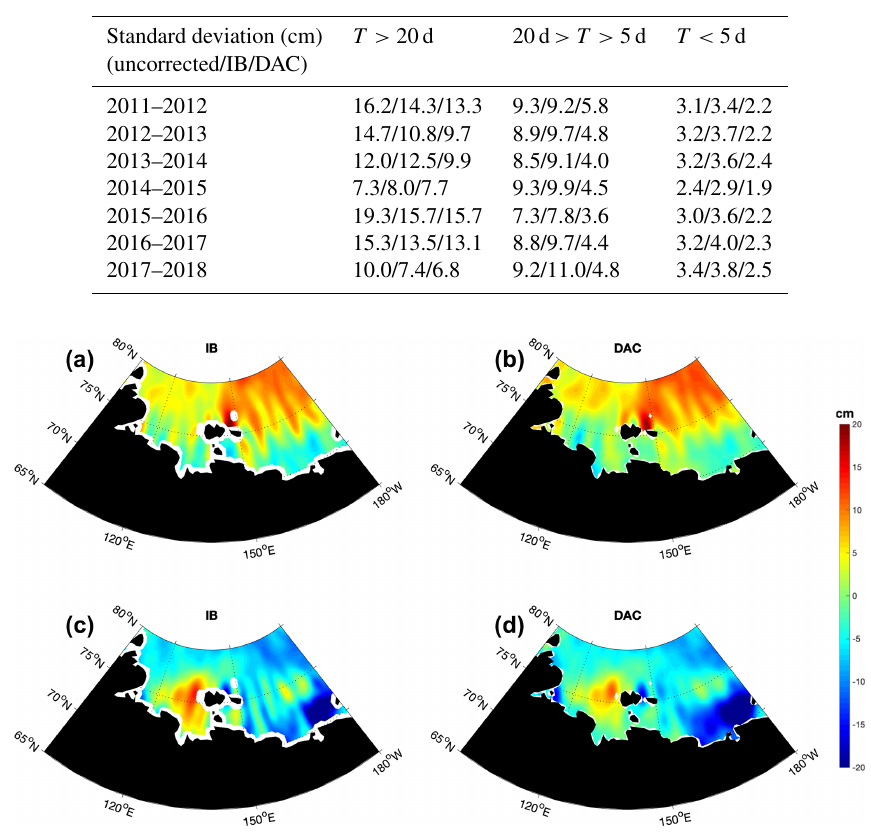
Figure B2. Effect of using correction DAC (b, d) instead of IB (a, c) on the monthly gridded η (cid:48) fields (see Sect. 4.3). Two examples are shown for the months of November 2014 (a, b) and November 2017 (c, d)